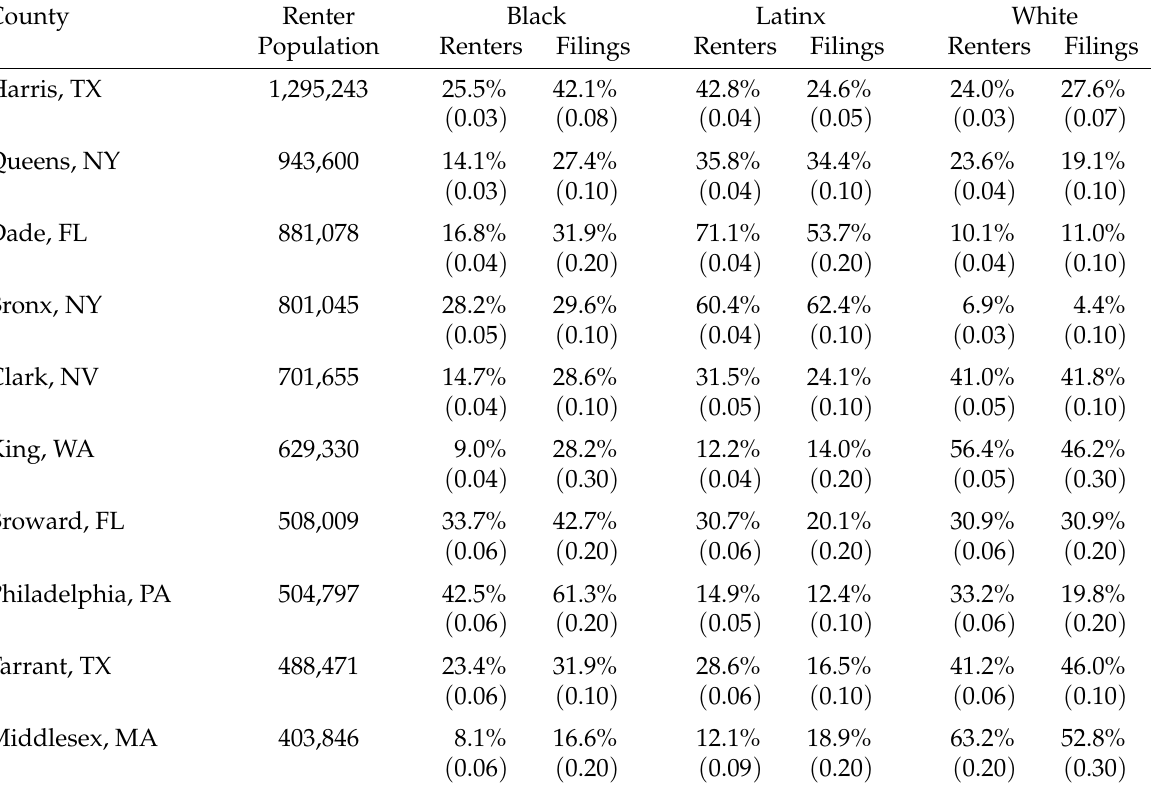
Table 1: Ten largest in-sample counties, by total renter